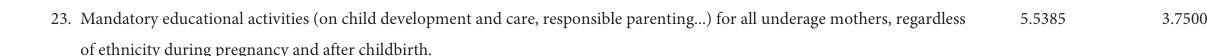
23. Mandatory educational activities (on child development and care, responsible parenting...) for all underage mothers, regardless of ethnicity during pregnancy and after